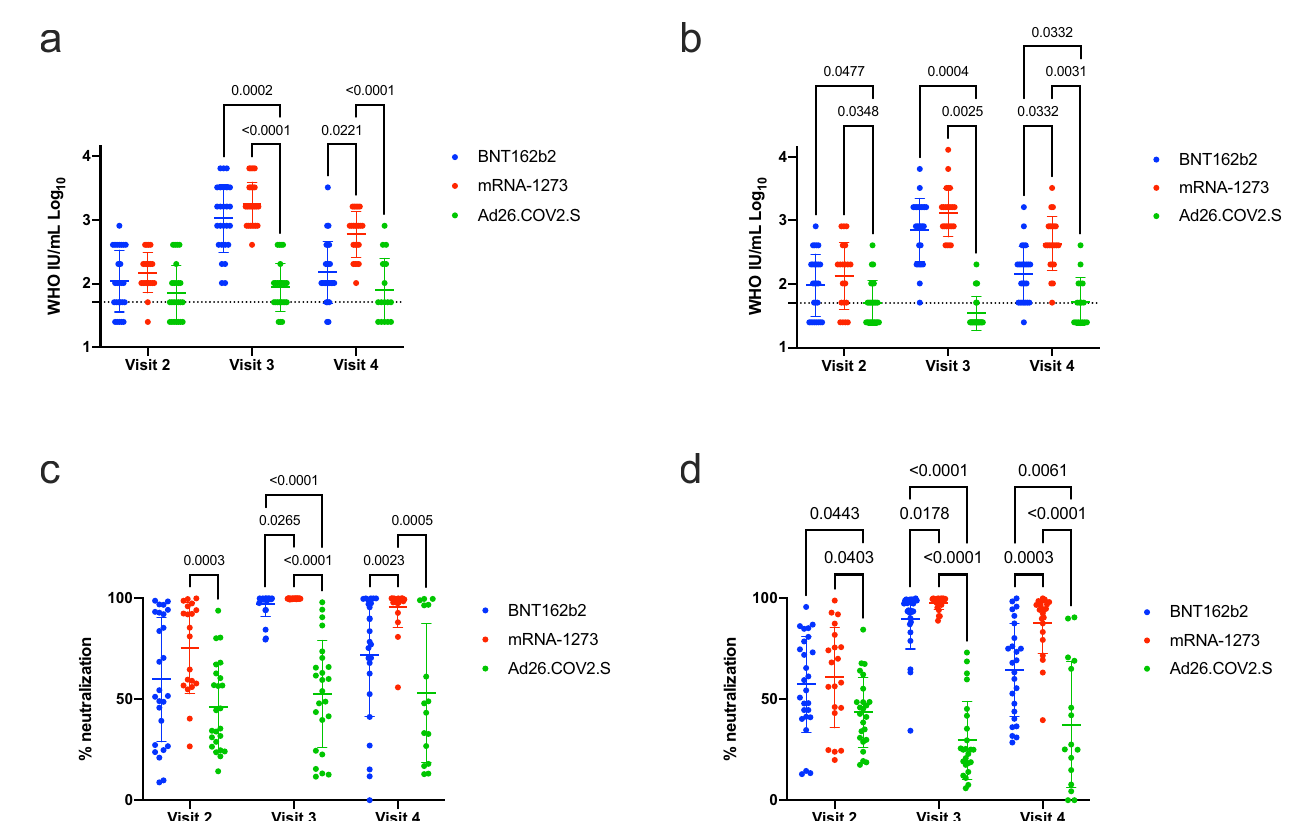
Fig. 2 SARS-CoV-2 neutralization amongst vaccine recipients. Plasma from each timepoint was tested by a SARS-CoV-2 neutralization assay using a WT parental strain ( a , c ) or the Delta variant ( b , d ). FRNT 50 data were converted to WHO IU/mL ( a , b ). Data are also shown as the percent of neutralization of input virus achieved at a 1:20 dilution of plasma ( c , d ). Each data point is shown, the geometric mean and geometric standard deviation ( a , b ) or mean and standard deviation ( c , d ) are plotted. The limit of detection for the FRNT 50 assay is a WHO IU/ mL titer of 51, indicated by a dotted line. Statistically signi fi cant differences using a mixed effects model with the Geisser-Greenhouse correction for unequal variance and Holm-Sidak multiple comparison test are noted by the respective p value.